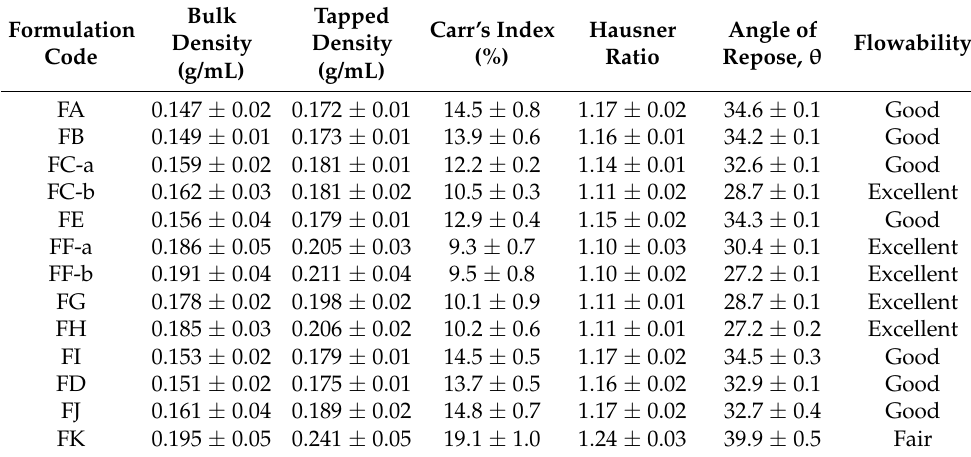
Table 3. Powder flow properties obtained from developed DPI formulations from flowability param- eter measurements [n = 3, Mean ±